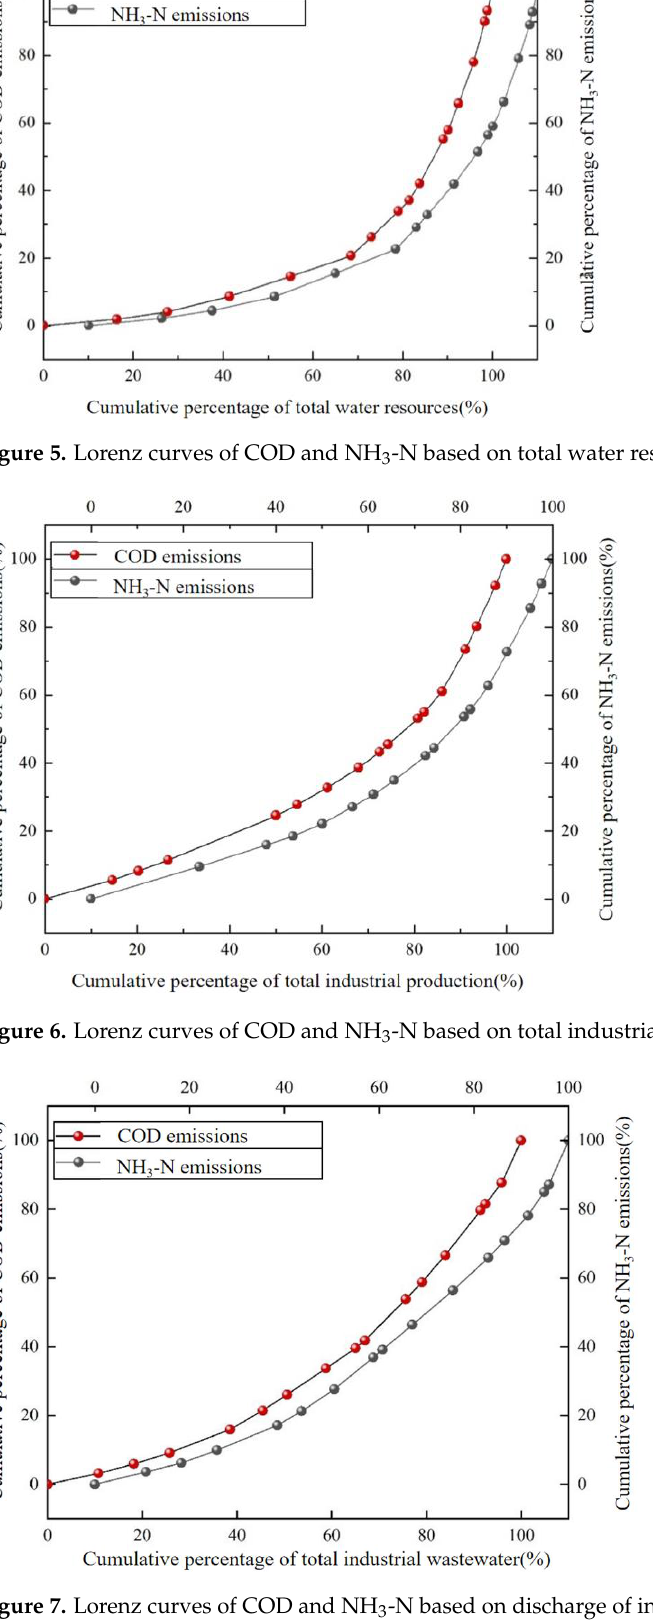
Figure 7. Lorenz curves of COD and NH 3 -N based on discharge of industrial wastewater indicators.